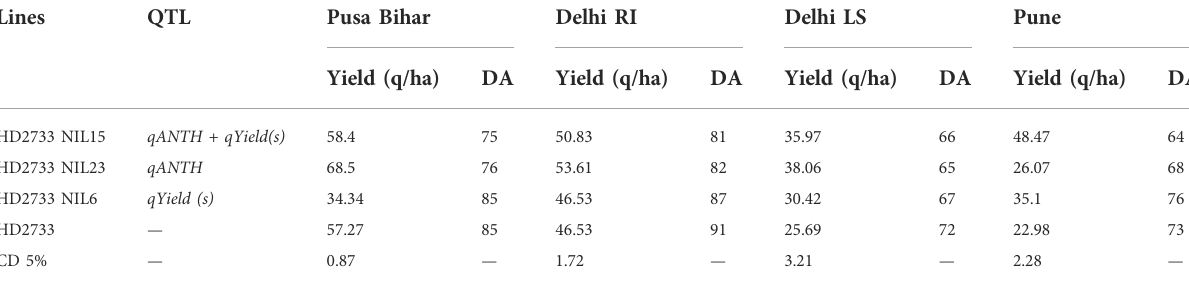
TABLE 7 Multi-location evaluation of the selected homozygous NILs.